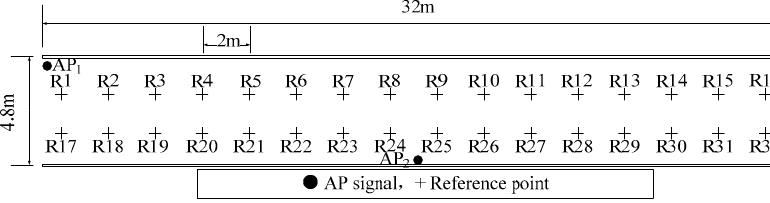
Figure 8. Plan of experiment tunnel with radio fingerprint database comparison.